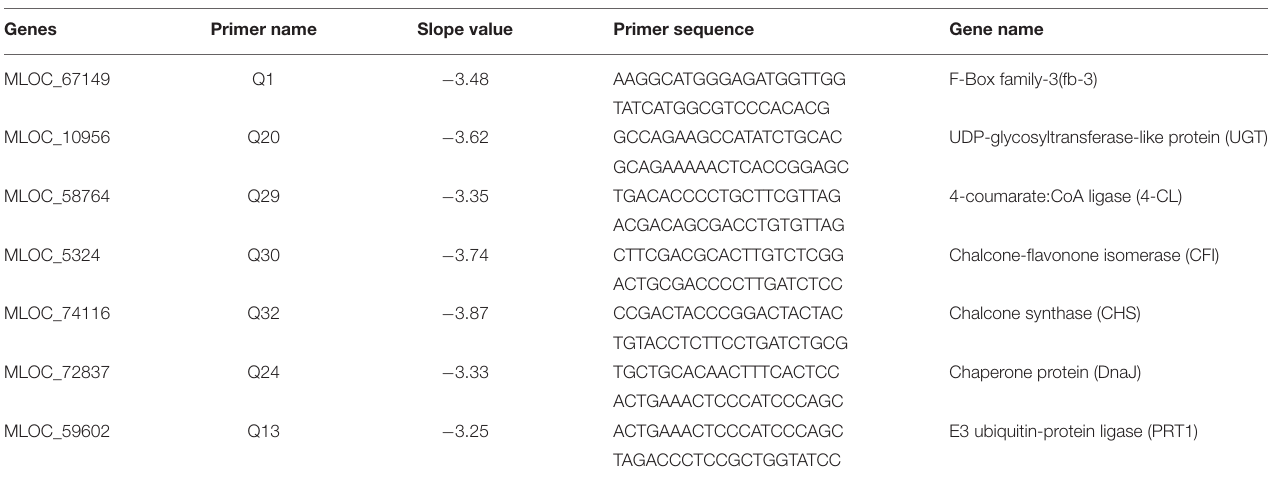
TABLE 2 | Primer used in